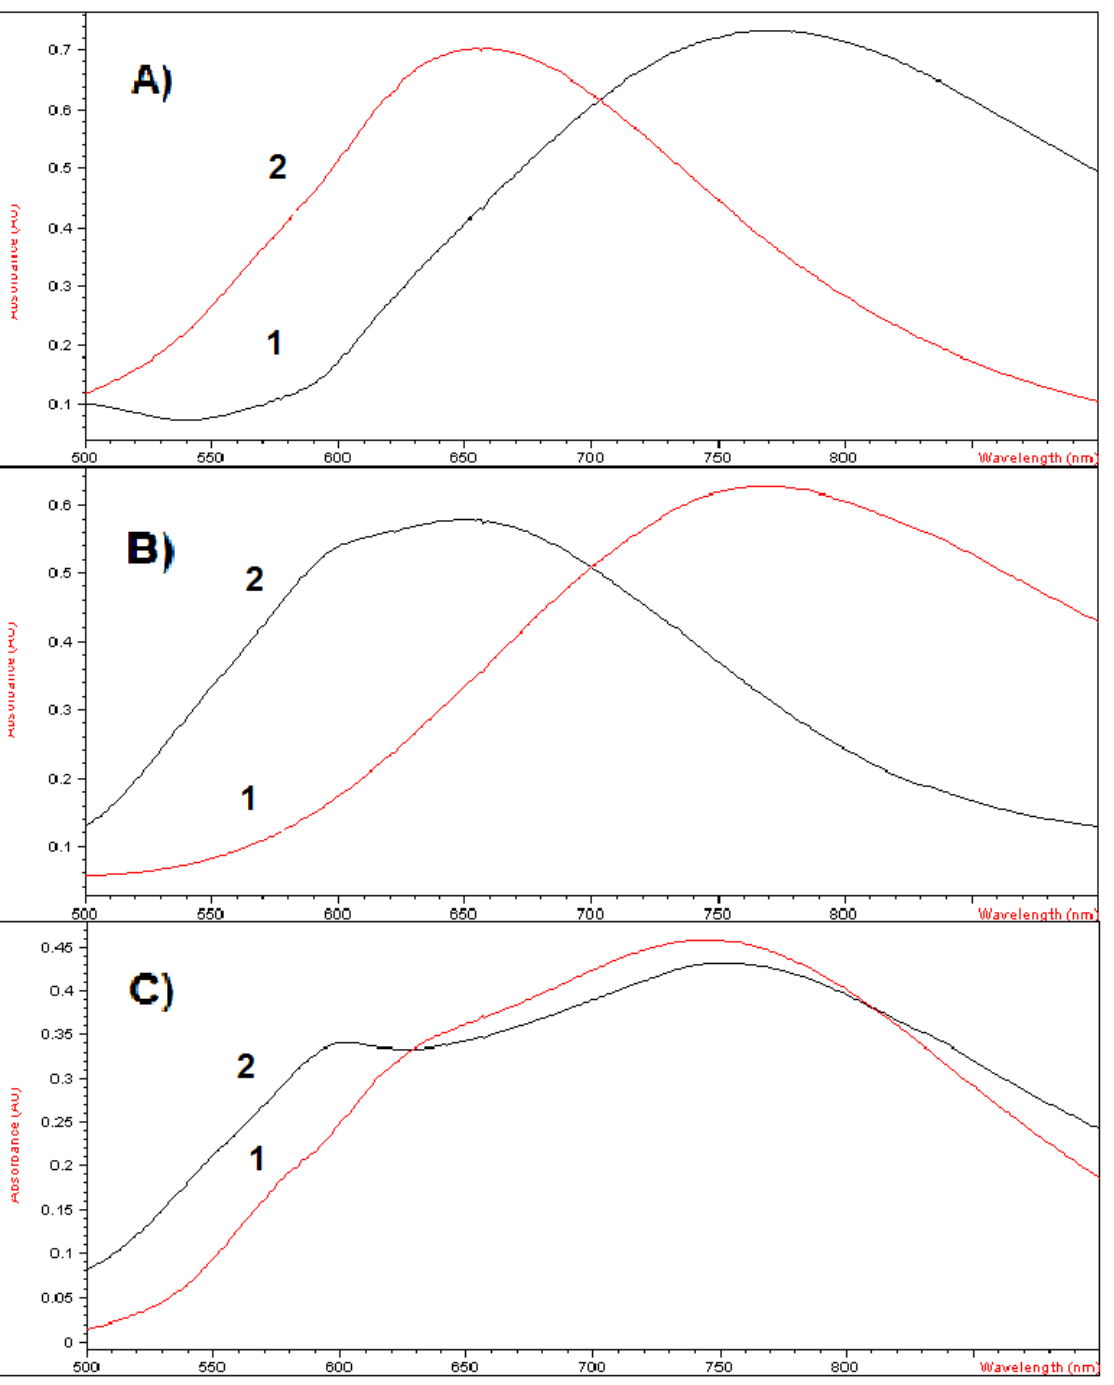
Figure 2. Visible spectra of ( A ) 1.14 × 10 − 3 M of [Cu(L 1 )Cl]PF 6 ( 1-Cl ), ( B ) 8.87 × 10 − 4 M of [Cu(L 4 )Cl]ClO 4 · H 2 O ( 4-Cl ), and ( C ) 8.00 × 10 − 4 M of [Cu(L 3 )ClO 4 ]ClO 4 ( 3-ClO 4 ) in CH 3 CN (1) and CH 3 CN/H 2 O (1:1 by volume) (2) solutions.